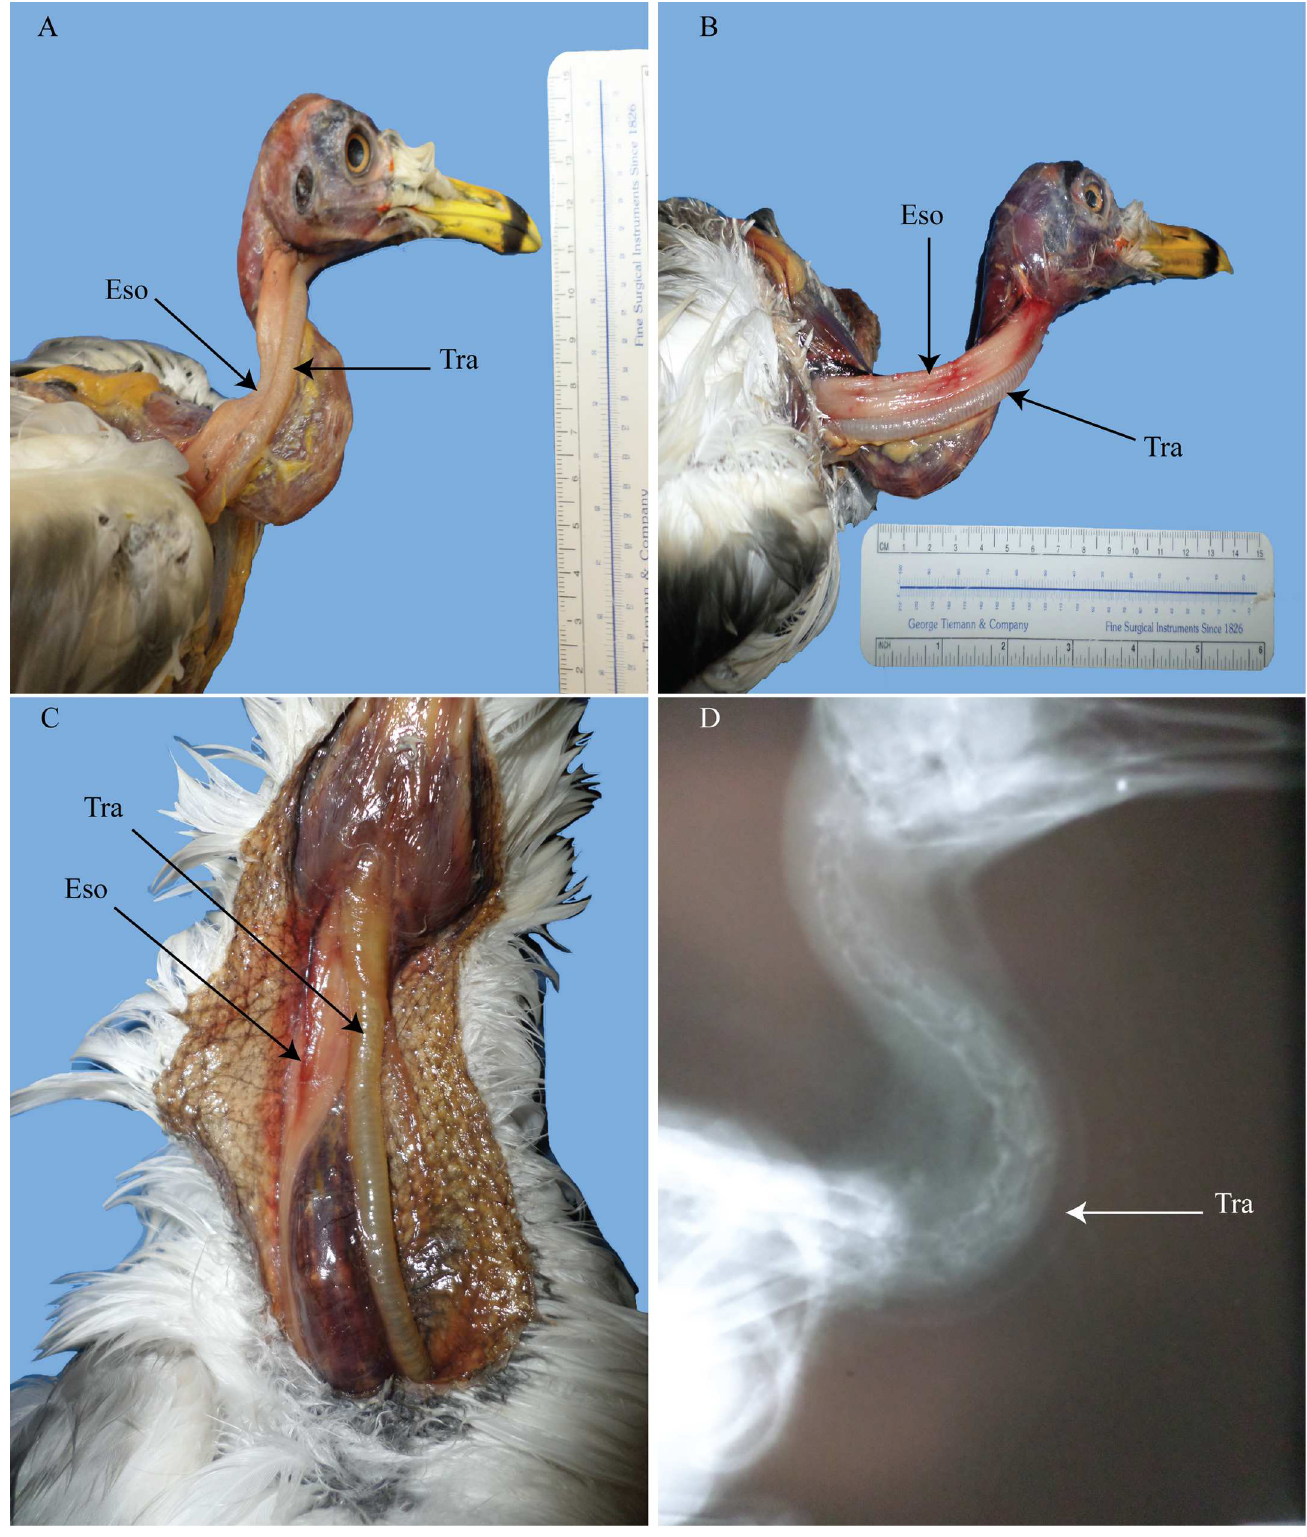
Fig 9. Larusdelawarensis . (A) lateralview of ring-billedgull. (B) lateralview of ring-billedgull. (C) ventral view of ring-billed gull showing the trachea on the left side of the neck. (D) radiograph of the gull fromC with a left ventrolateral trachea.